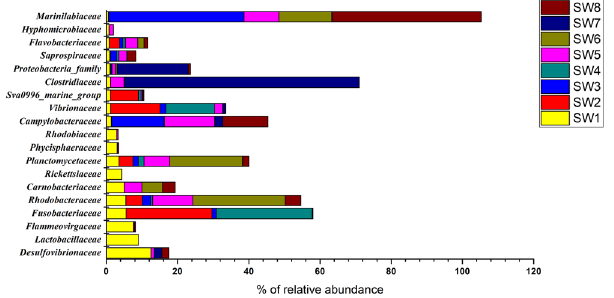
Figure 2. Relative abundance and distribution of epiphytic bacterial families on seaweed